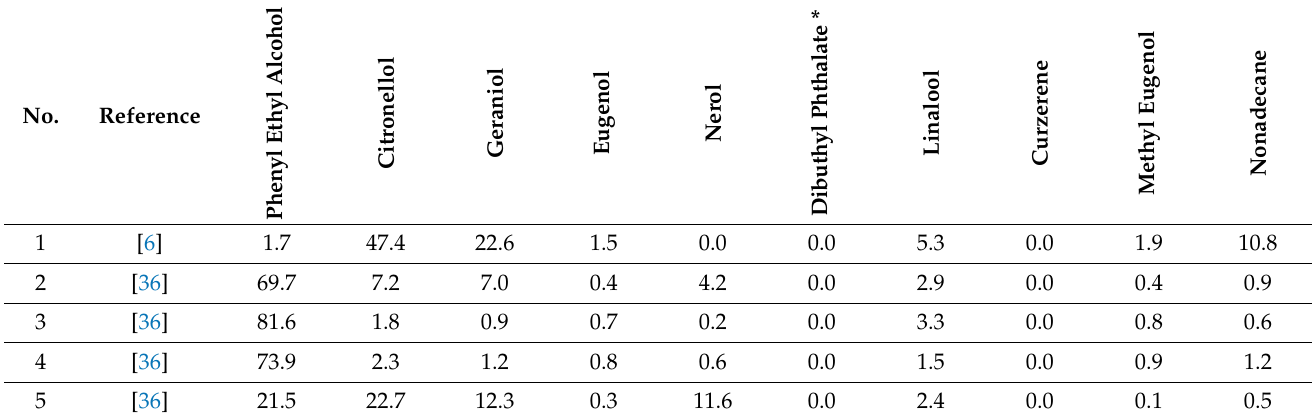
Figure 1. The unrooted cluster tree for different Rosa sp. hydrosols samples (according to Table 2). Table 2. Volatile compounds (represented in percentages, %) of different rose hydrosols according to